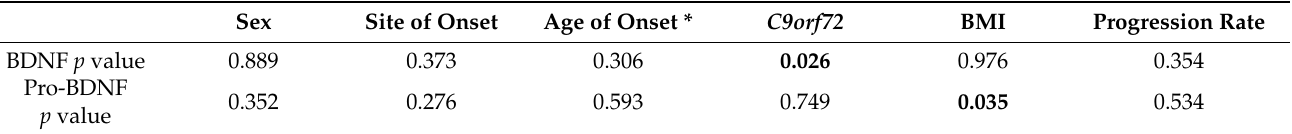
Table 4. Associations of serum BDNF and Pro-BDNF levels with clinical variables of ALS patients. Sex Site of Onset